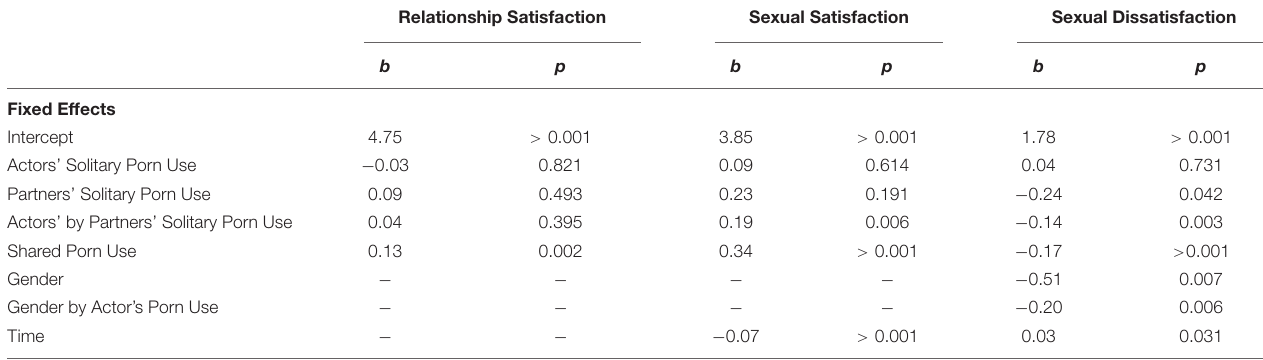
TABLE 9 | Linear mixed models predicting relationship and sexual satisfaction for Study 4 ( N = 277 couples). Relationship Satisfaction Sexual